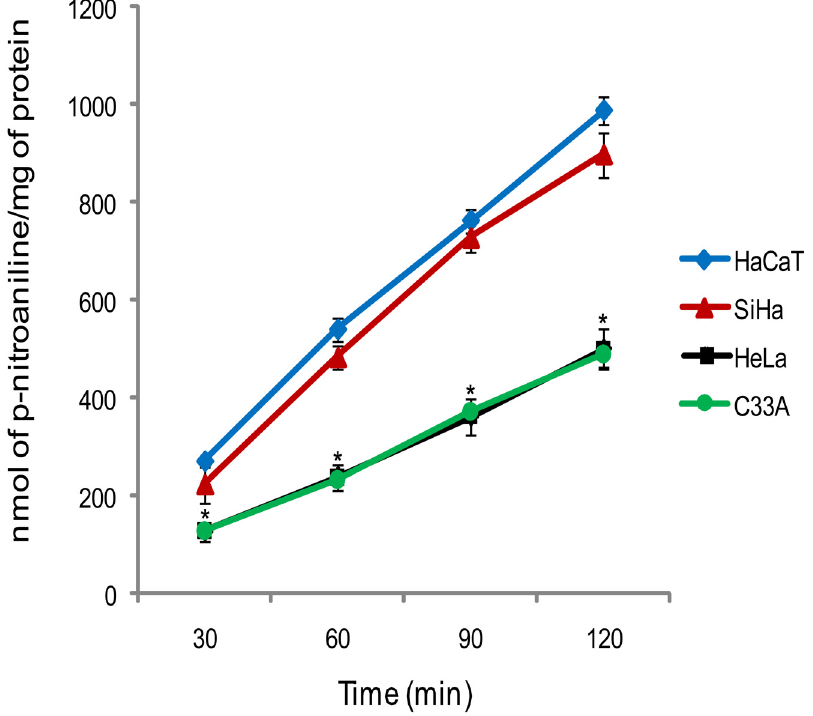
Fig 1. Time course curve for Gly-Pro-p-nitroanilide hydrolysis in adherent cells monolayer. Results are mean values ± SD for three experiments. * Indicates statistical significance when cervical cancer cell lines were compared to the non-tumorigenic cell line, HaCaT (ANOVA followed by Tukey ’ s test, p (cid:1) 0.05).